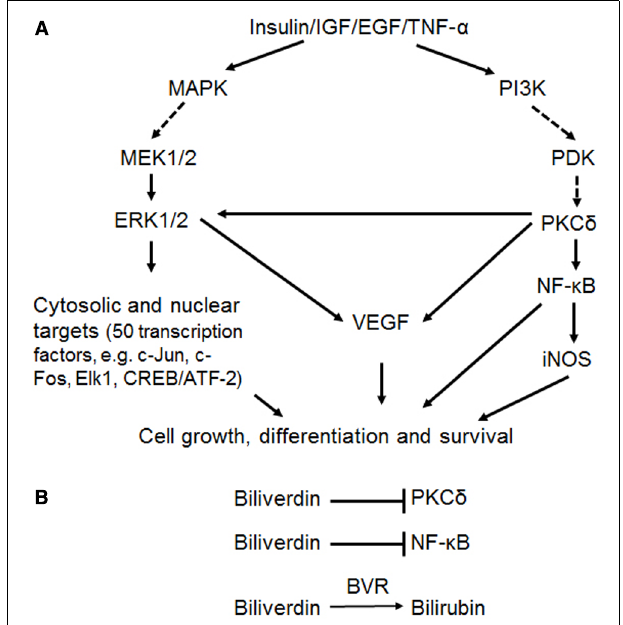
FIGURE 1 | (A) Simplified representation of the two major arms of signal transduction from cellular receptors, in particular, those for insulin and growth factors. Solid arrows indicate reactions wherein BVR has been demonstrated to act as a scaffold, molecular bridge, intracellular transporter, transcription factor or kinase. In the case of activation of VEGF expression by ERK1/2 and/or PKC d , this follows as a consequence of BVR-dependent stimulation of kinase activities. (B) Three mechanisms of BVR function as a cytoprotectant. The reductase activity converts biliverdin to the antioxidant bilirubin. In addition, biliverdin is a known inhibitor of PKC d (Miralem et al., 2012) and of NF- k B (Gibbs and Maines,